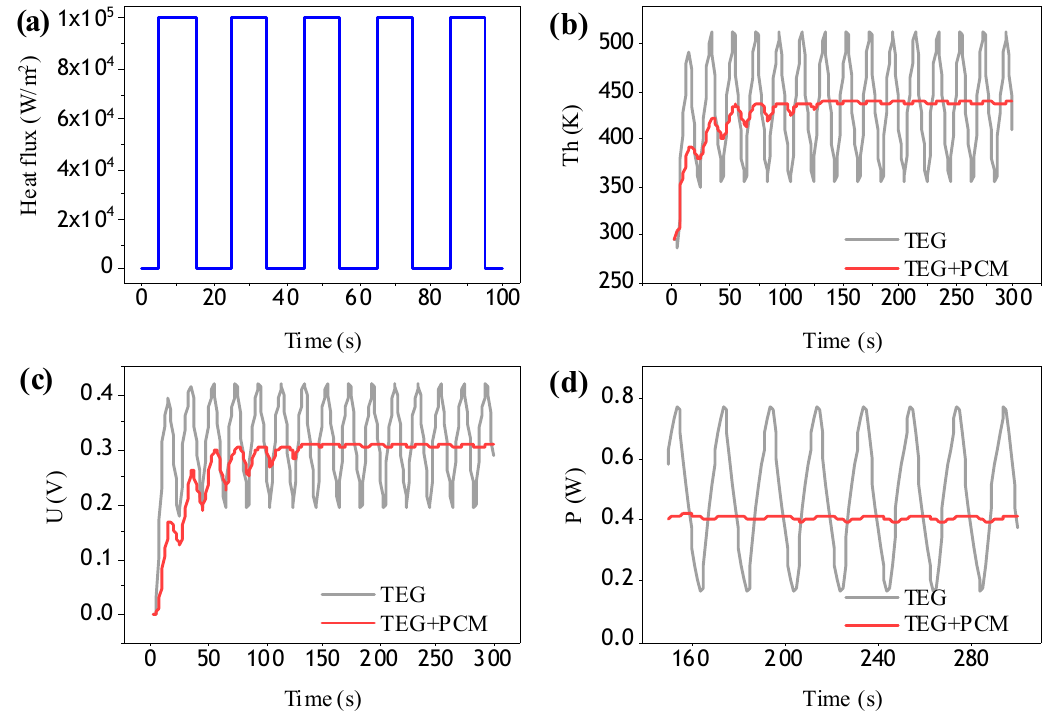
Figure 5. ( a ) Regular pulse heat flow; ( b ) Temperature curve; ( c ) Voltage curve; ( d ) Power curve.